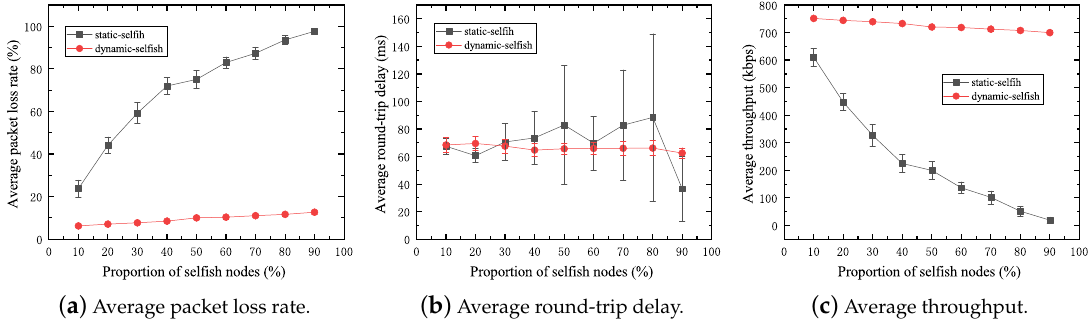
Figure 8. Performance impact of various proportions of selfish nodes (50 nodes). The average packet loss rate of the network increases with increasing proportions of selfish nodes in both dynamic and static selfish networks (Figure 8a). A large proportion of selfish nodes leads to a high packet loss rate in the MANET. The average packet loss rate of the network with static selfish nodes increases drastically. This significant performance reduction is caused by the fact that the absolute number of selfish nodes increases with the increasing proportion of selfish nodes in the network, which finally leads to very few intermediate nodes in the network to assist in routing and forwarding tasks. However, that of the network with dynamic selfish nodes, by contrast, does not increase obviously. The reason is that even though the proportion of dynamic selfish nodes is high, it does not mean the absolute number of selfish nodes is large. In the network with dynamic selfish nodes, the node selfishness is only determined by the dynamic residual energy level. The nodes with higher residual energy levels always act altruistically, and vice